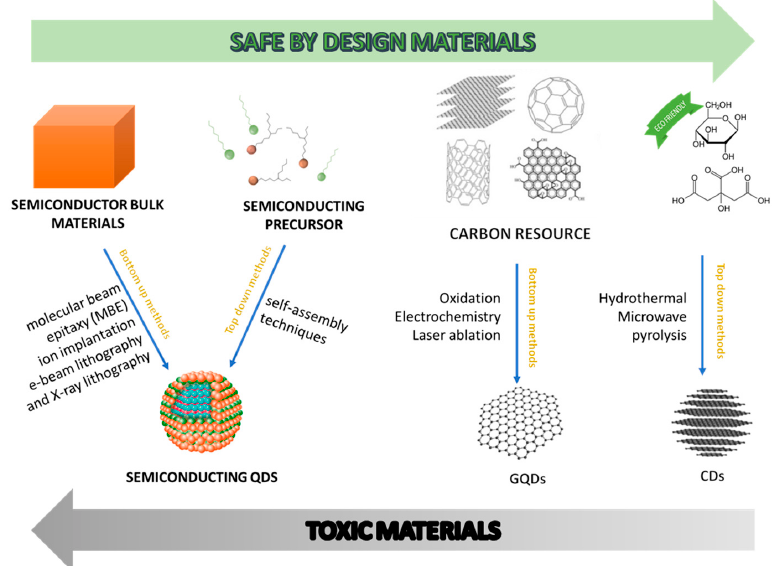
Figure 2. Schematic representation of carbon dots’ main characteristics: adapted with permission from [14], copyright 2019 American chemical society, and adapted with permission from [41], copyright 2017 Elsevier.